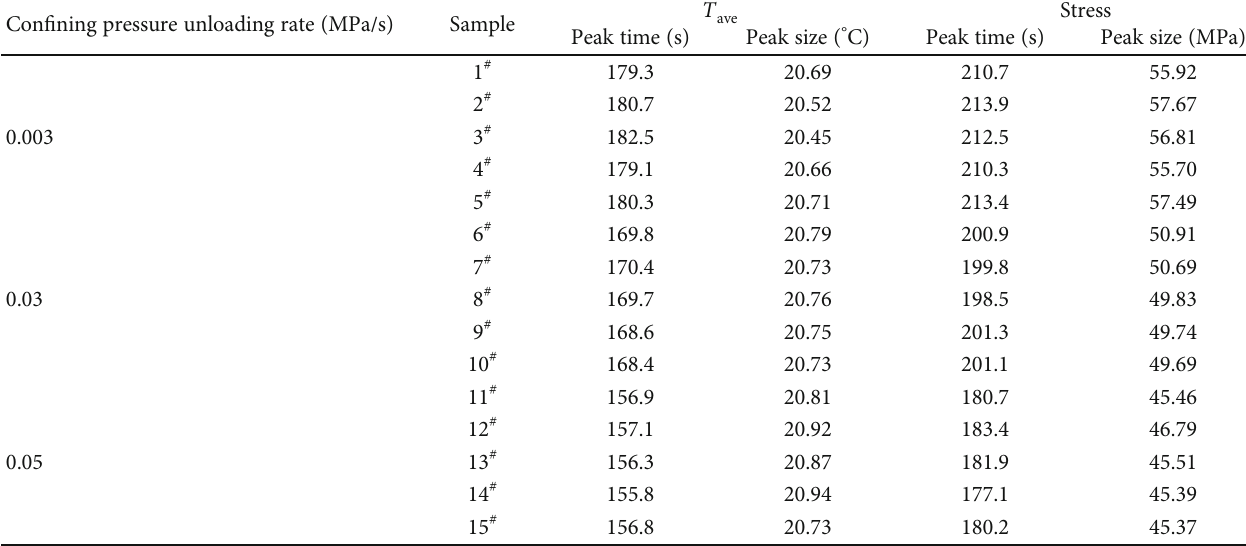
ff erent pressure relief